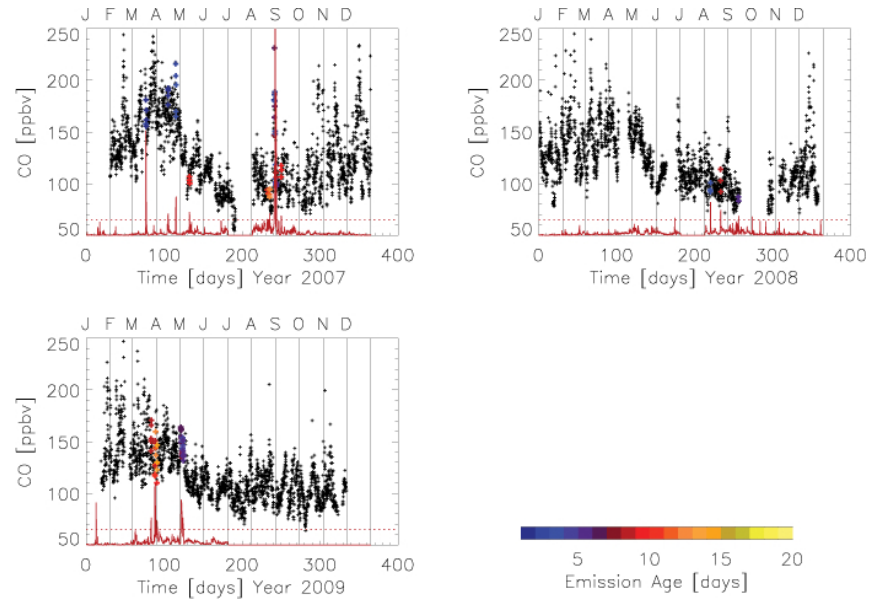
Fig. 3a. Time series of observed CO at ICO-OV (black dots) with FLEXPART CO fire (red line). Observations at ICO-OV are tagged with the FLEXPART fire emission age (colour scale) when FLEXPART fire CO exceeded 10ppb. FLEXPART CO fire is plotted with a positive constant bias of 50ppb to reduce the extent of y-axis.